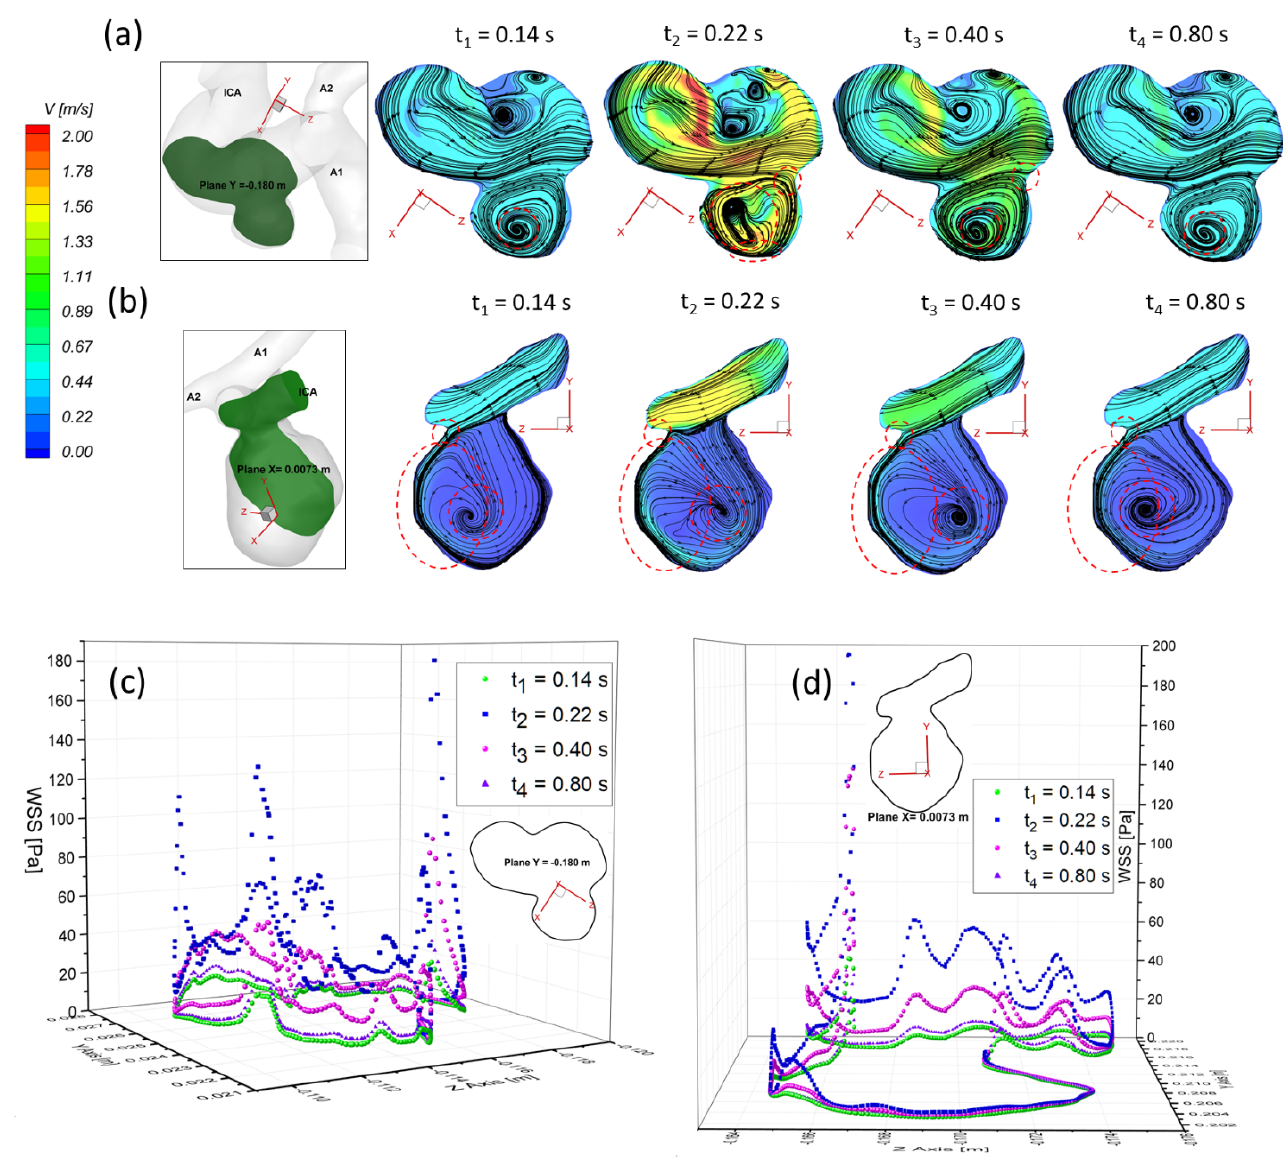
Figure 13. Velocity profiles and flow streamlines in selected planes and WSS distributions on the edges of selected planes in ICASA−1 and ICASA−2 models at selected instants: ( a ) velocity profiles and streamlines in plane Y = −0.180 m of ICASA−1 model, ( b ) velocity profiles and streamlines in plane X = 0.0073 m of ICASA − 2 model, ( c ) WSS distributions at the edges of plane Y = − 0.180 m of ICASA − 1 model, and ( d ) WSS distributions at the edges of plane X = 0.0205 m of ICASA −